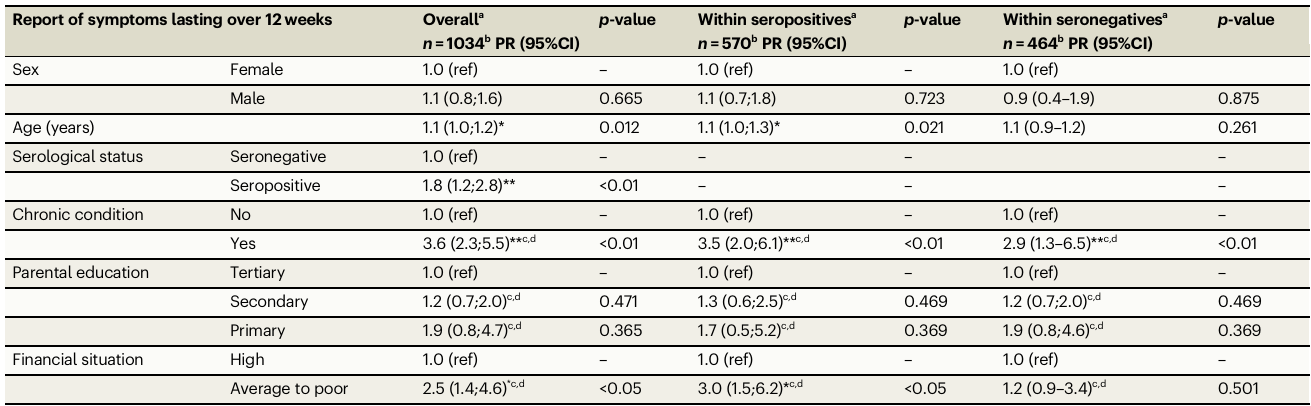
Table 3 | Adjusted prevalence ratio of symptoms lasting over 12 weeks Report of symptoms lasting over